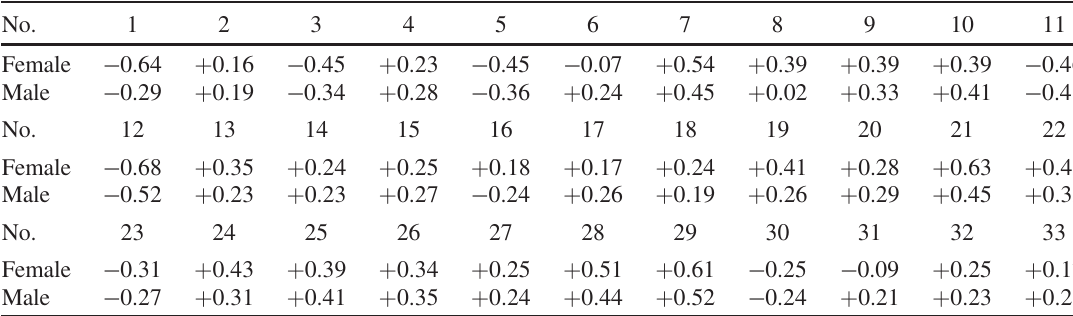
TABLE VII. Normalized scores on each item for male and female students.